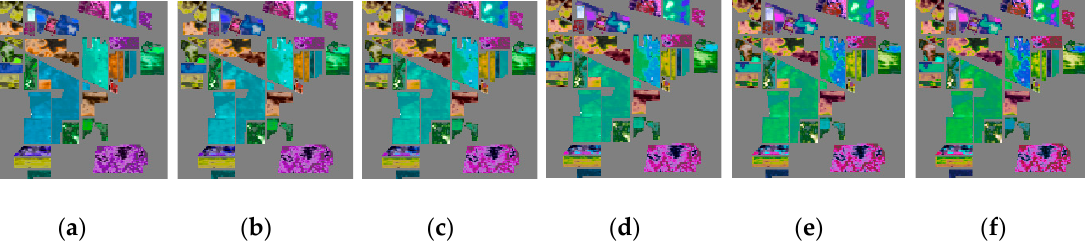
Figure 11. Indian Pines image display results under six different r values. ( a ) r = 0; ( b ) r = 0.0038; ( c ) r = 0.0077; ( d ) r = 0.0115; ( e ) r = 0.0154; ( f ) r = 0.0183.